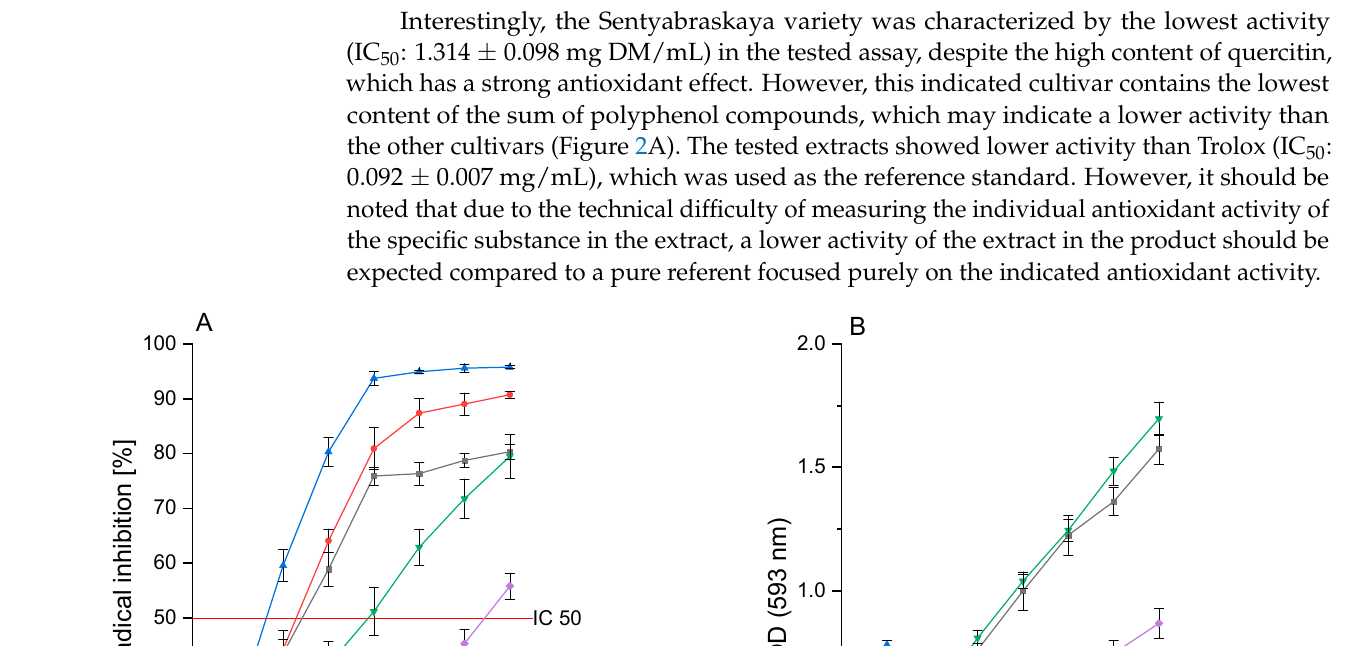
Ability to Inhibit Enzymes [mg DM **/mL]